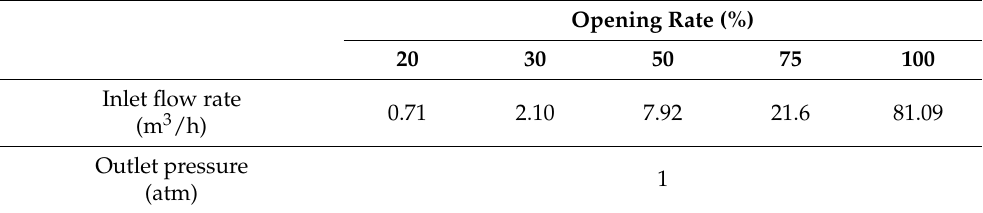
Table 1. The boundary conditions of the CFD analysis according to the opening rates.